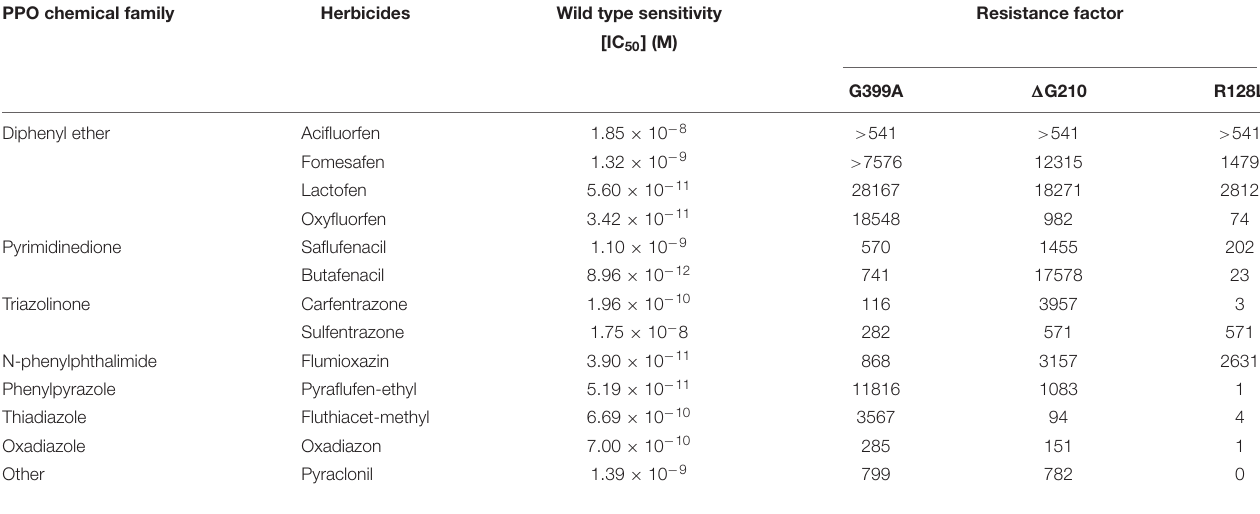
TABLE 2 | Effects of protoporphyrinogen oxidase (PPO) inhibitors on in vitro enzyme activity of recombinant Amaranthus tuberculatus PPO2 wild-type enzyme and resistant enzyme variants. PPO chemical